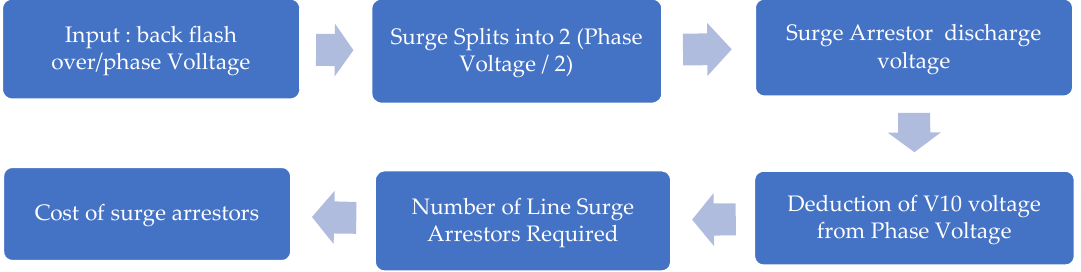
Figure 7. The process used to calculate the required number of surge arrestors.